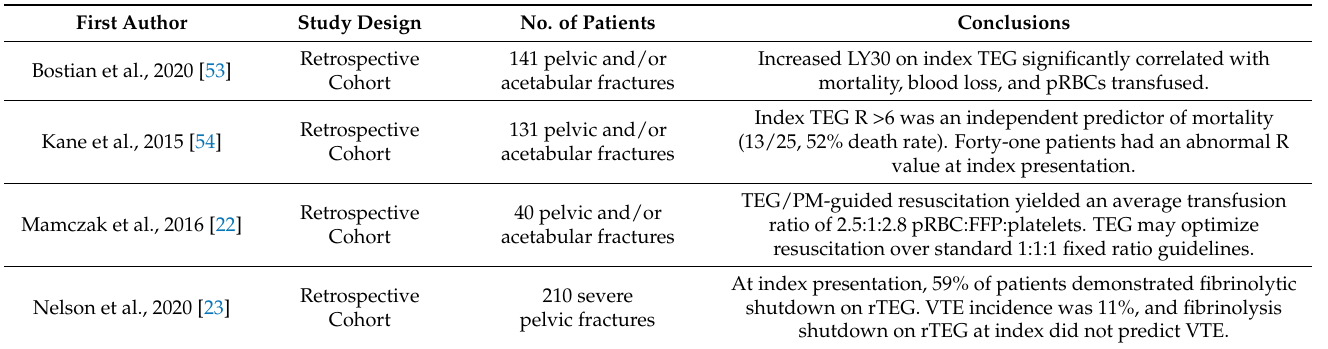
Table 2. Summary of the literature pertaining to viscoelastic hemostatic assays applied for the treatment of patients with pelvic